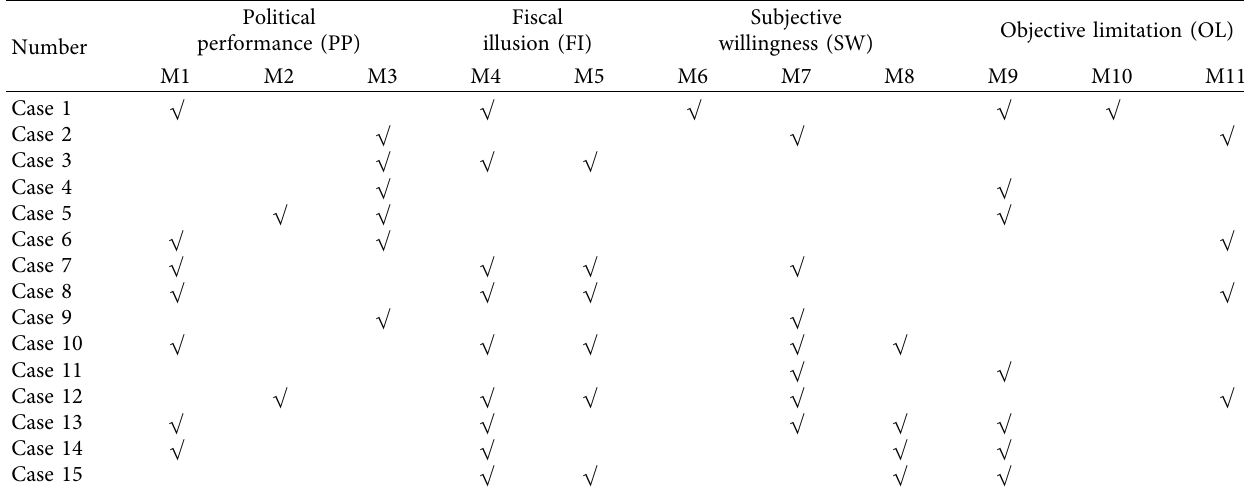
Table 6: Results of each case under each logic.